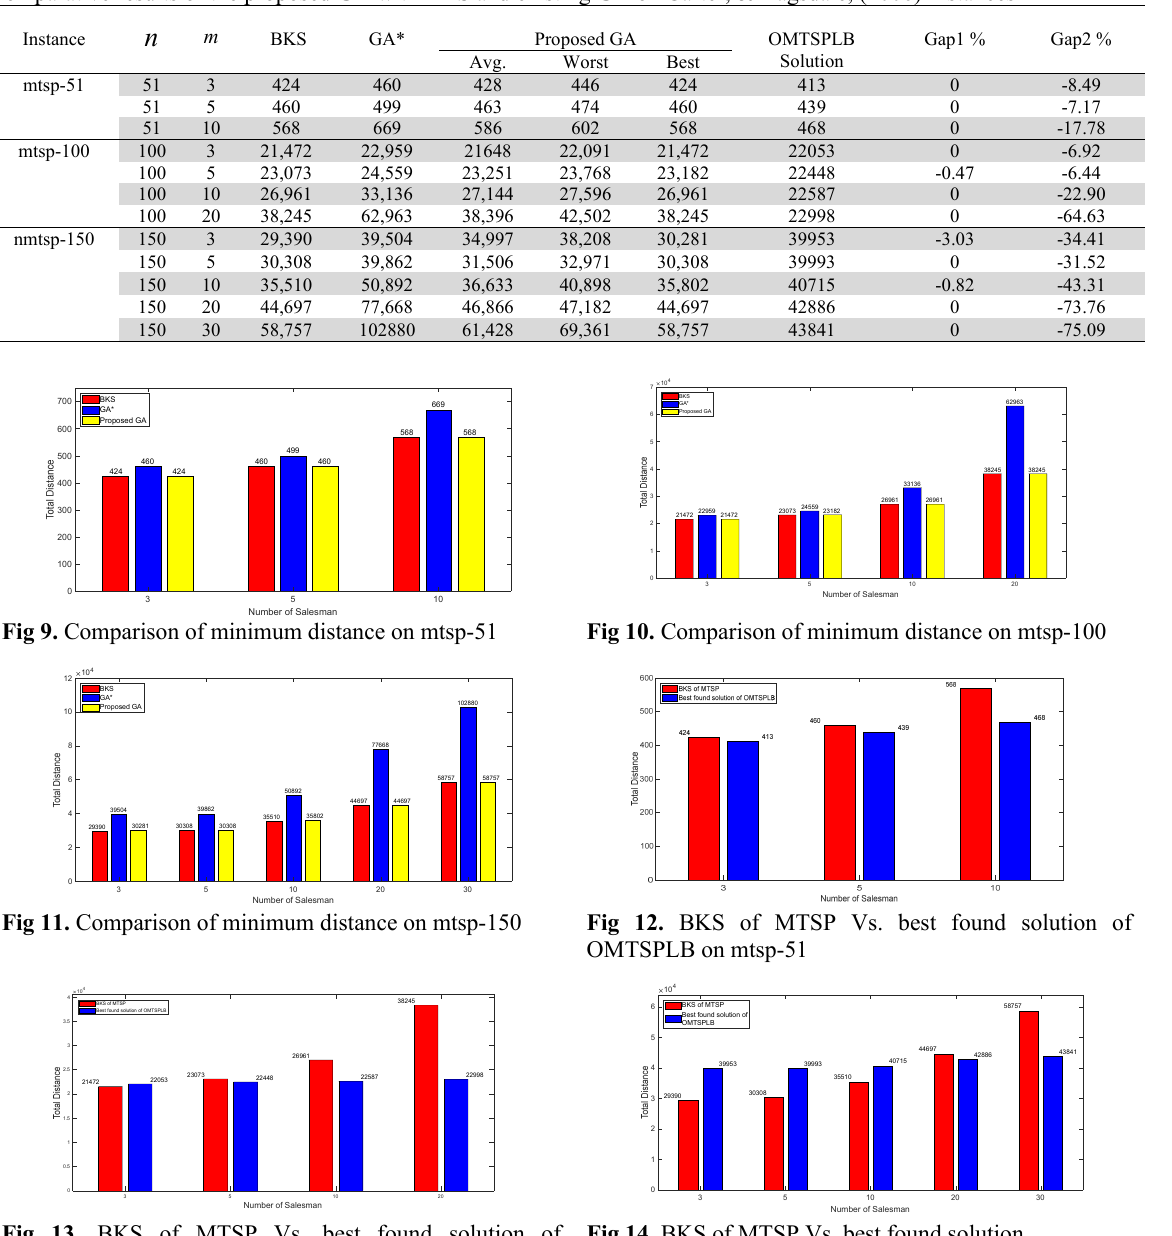
Fig 13. BKS of MTSP Vs. best found solution of OMTSPLB on mtsp-100